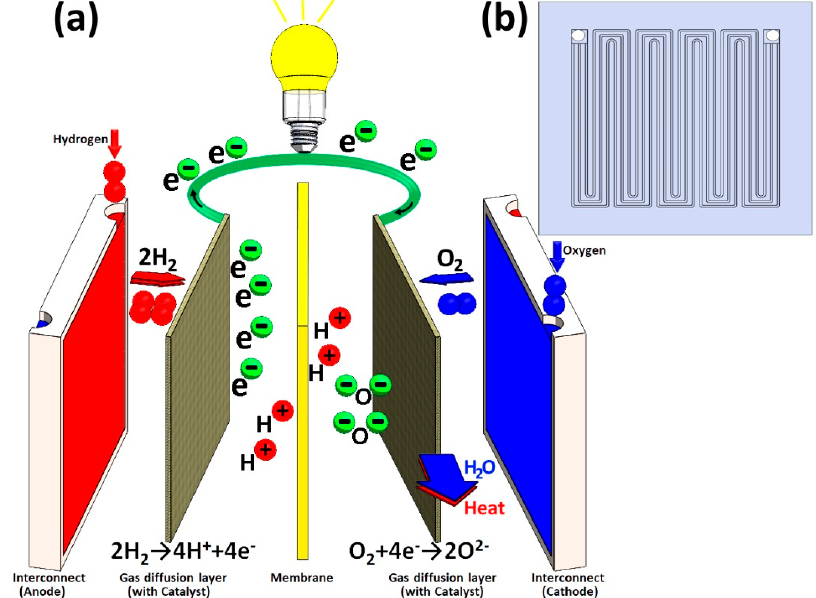
Figure 1. Schematic of Proton Exchange Membrane (PEM) fuel cell components ( a ) and front plane of Proton Exchange Membrane Fuel Cells (PEMFC MI ) ( b ).